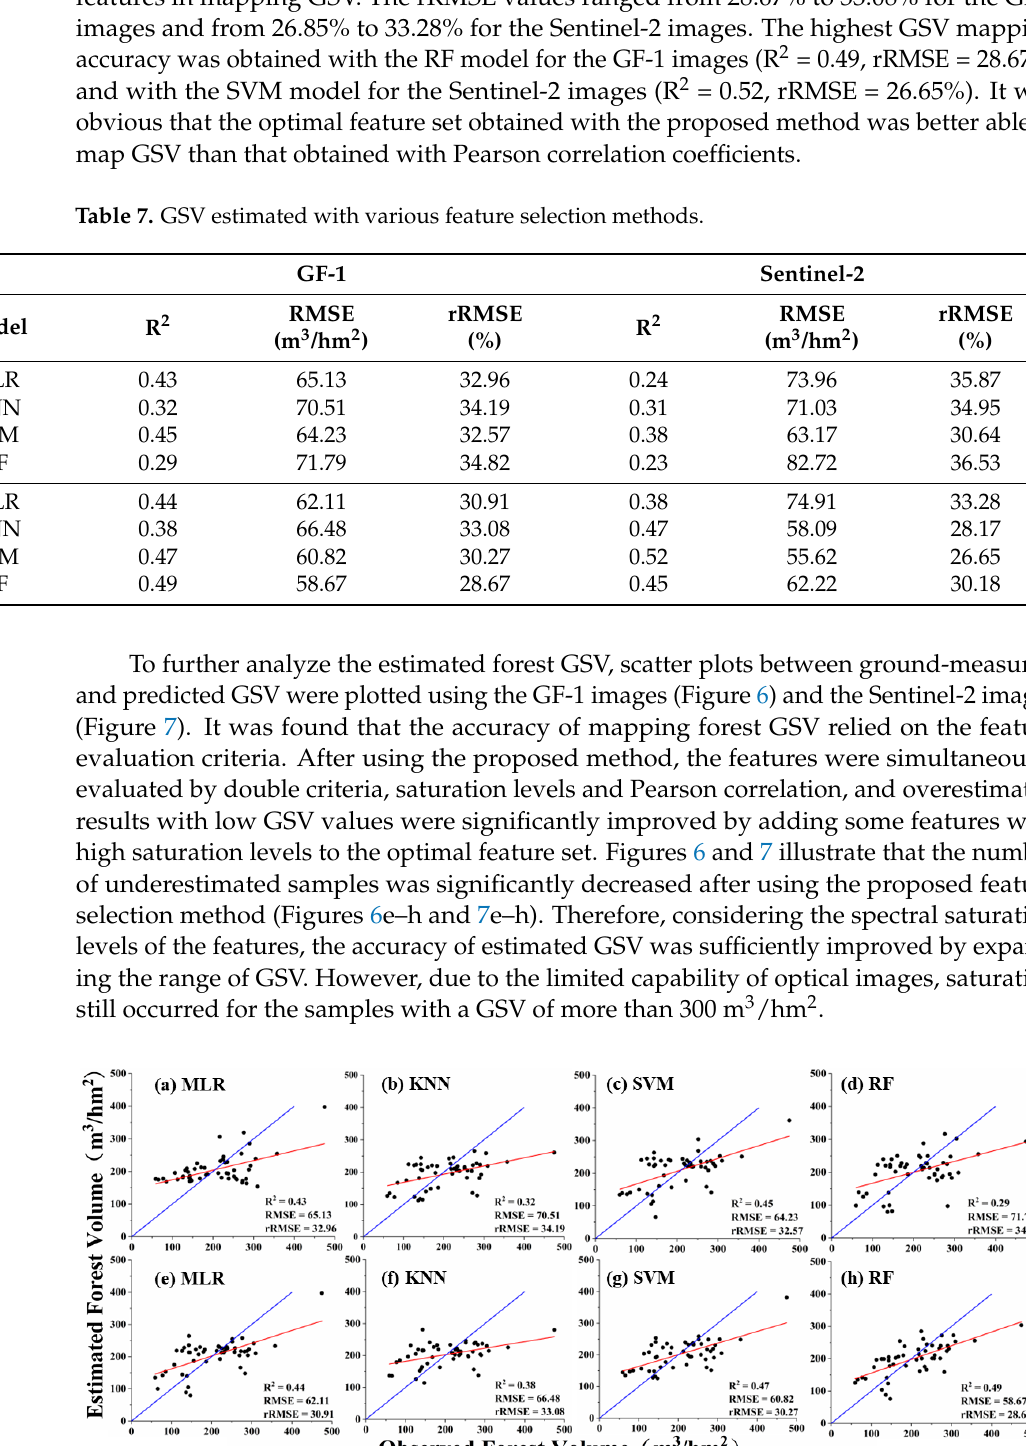
Figure 7. Scatter plots between measured and predicted GSV with different feature selection meth- ods and models using Sentinel-2 images; ( a – d ) show the results using Pearson correlation and ( e – h ) show the results using the proposed method. To describe the gaps between different feature criterion methods, two models (SVM and RF) were employed to map the planted Chinese fir forest using the GF-1 and Sentinel- 2 images (Figure 8). When using the optimal feature set obtained with the proposed method, the estimated GSV was obviously larger than that obtained with the Pearson cri- terion (Figure 8e–h). The gaps of the estimated GSV with different feature selection meth- ods were caused by the capabilities of the selected features. These results (Figure 9) illus- trate that the ranges of the estimated GSV were extended after adding some features with high saturation levels. For a forest with a low GSV (less than 100 m 3 /hm 2 ), overestimated results often occur when using an optimal feature set obtained with the Pearson criterion. After using the proposed method, the proportion of low GSV values (less than m 3 /hm 2 ) decreased from 13.00% to 3.37% for the GF-1 images and from 15.53% to 4.08% for the Sentinel-2 images. Meanwhile, the proportion of high GSV (ranging from 200 m 3 /hm 2 to 300 m 3 /hm 2 ) increased from 42.49% to 47.16% for the GF-1 images and from 40.47% to 50.86% for the Sentinel-2 images. It can be inferred that the sensitivity of the optimal fea- ture set and the accuracy of estimated GSV could be improved by viewing saturation lev- els as an evaluation criterion. However, once a forest’s GSV is larger than its saturation levels, the saturation phenomenon inevitably occurs in optical images.